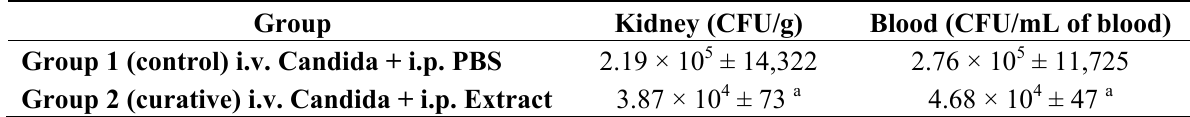
Table 1. Effect of methanolic extract of Cassia fistula seed on Candida albicans recovered from kidney and blood of